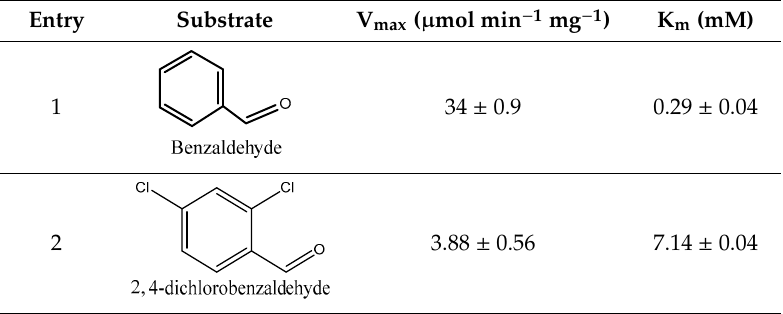
Table 2. Kinetics of CpCR.